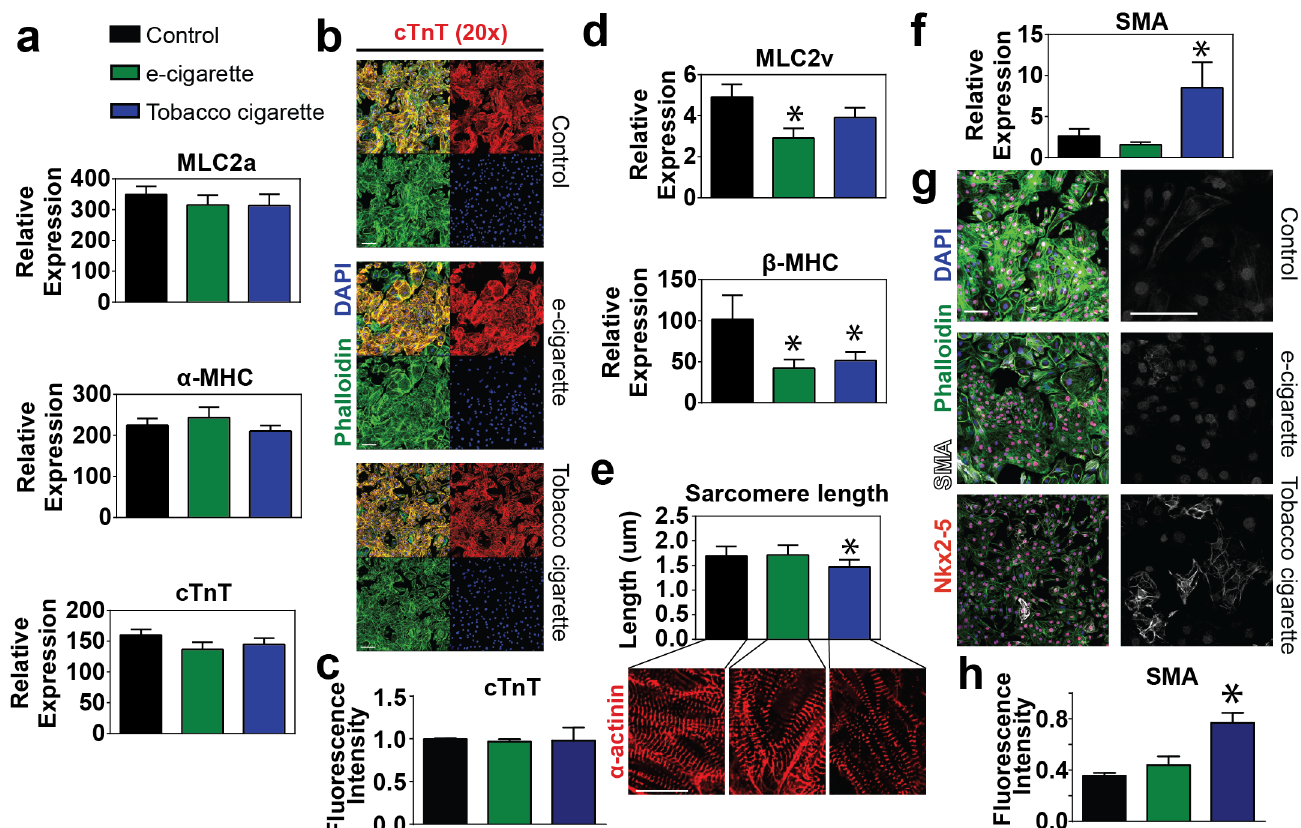
Fig 6. Analysis of cardiac myofilament and structural protein expression. (a) Quantitative RT-PCR analysis of early developmental myofilament proteins including the atrial myosin light chain MLC2a, the myosin isoform α -MHC and cardiac troponin T (cTnT) in cells treated with 6.8 μ M e-cigarette or tobacco cigarette extracts vs. control. (b-c) Immunohistochemistry (b) and quantification (c) of the myofilament proteins cardiac troponin T (cTnT) in combination with phalloidin and nuclear counterstain DAPI in control cells or those treated with 6.8 μ M e-cigarette or 6.8 μ M tobacco cigarette extracts. Scale bar = 100 μ m for cTnT. (d) Quantitative RT-PCR analysis of mature developmental myofilament isoforms including the ventricular myosin light chain MLC2v and the myosin isoform β -MHC in cells treated 6.8 μ M e-cigarette or tobacco cigarette extracts vs. control. (e) Quantitation of sarcomere length as measured from samples stained for α -actinin by immunohistochemistry comparing control vs. 6.8 μ M e-cigarette or tobacco cigarette. (f-h) Quantitative RT-PCR (f) immunohistochemistry (g) and quantification of IHC (h) for the immature cardiac marker smooth muscle actin (SMA) in control vs. cells treated with 6.8 μ M e- cigarette or tobacco cigarette extract. n (cid:3) 6 per group. Scale bar = 100 μ m. * P < 0.05. (6.8 μ M) were isolated and profiled for 26 different stress related proteins including redox en-